Question: Describe this figure in one sentence.
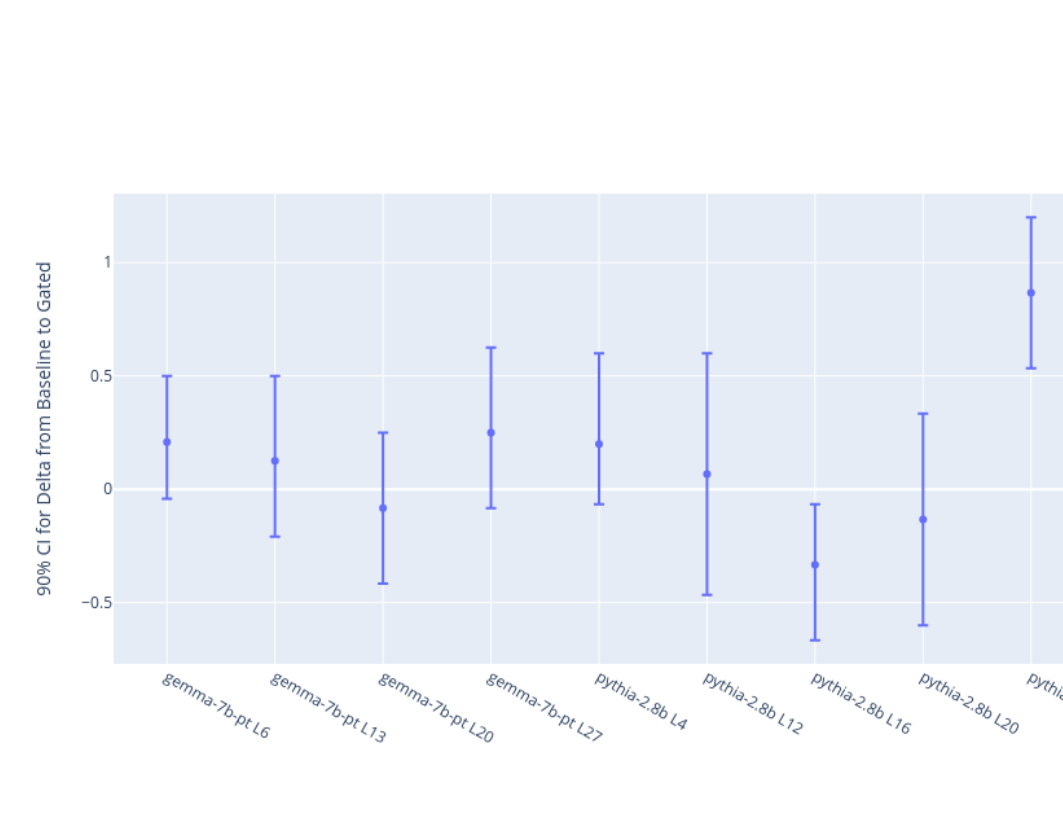
Answer: | Per-layer 90% confidence intervals for the Gated-vs-Baseline label difference